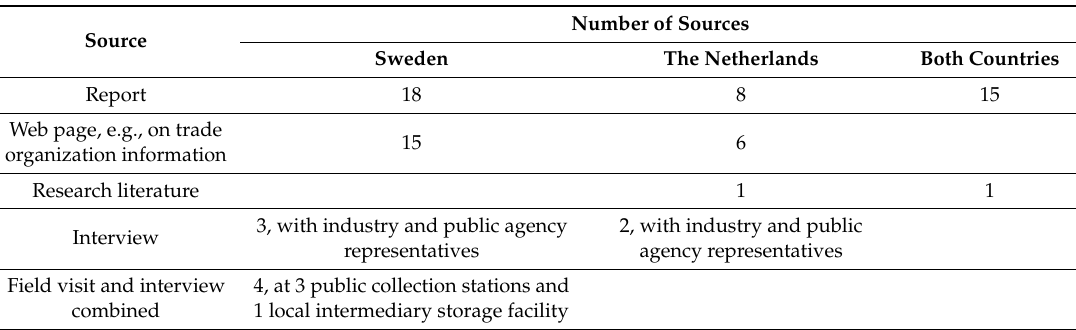
Table 1. Data collection: sources and